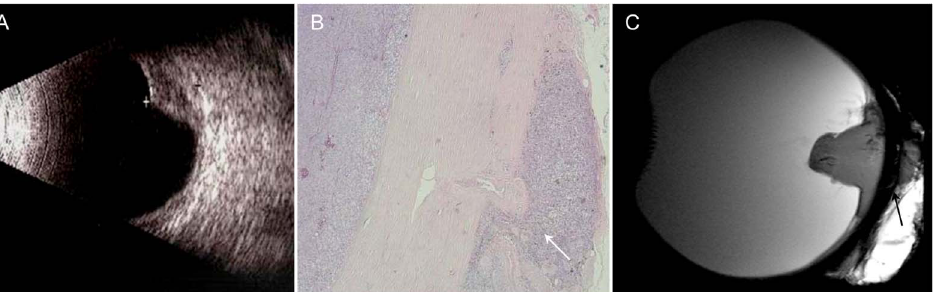
Figure 1. 83-year-old patient with choroidal melanoma infiltrating the retrobulbar fat. A – Sonography: dome-shaped tumor of low reflectivity with a highly reflective surface. No information on extraocular tumor extension. B – H&E stain, 2 6 magnification: infiltration of the